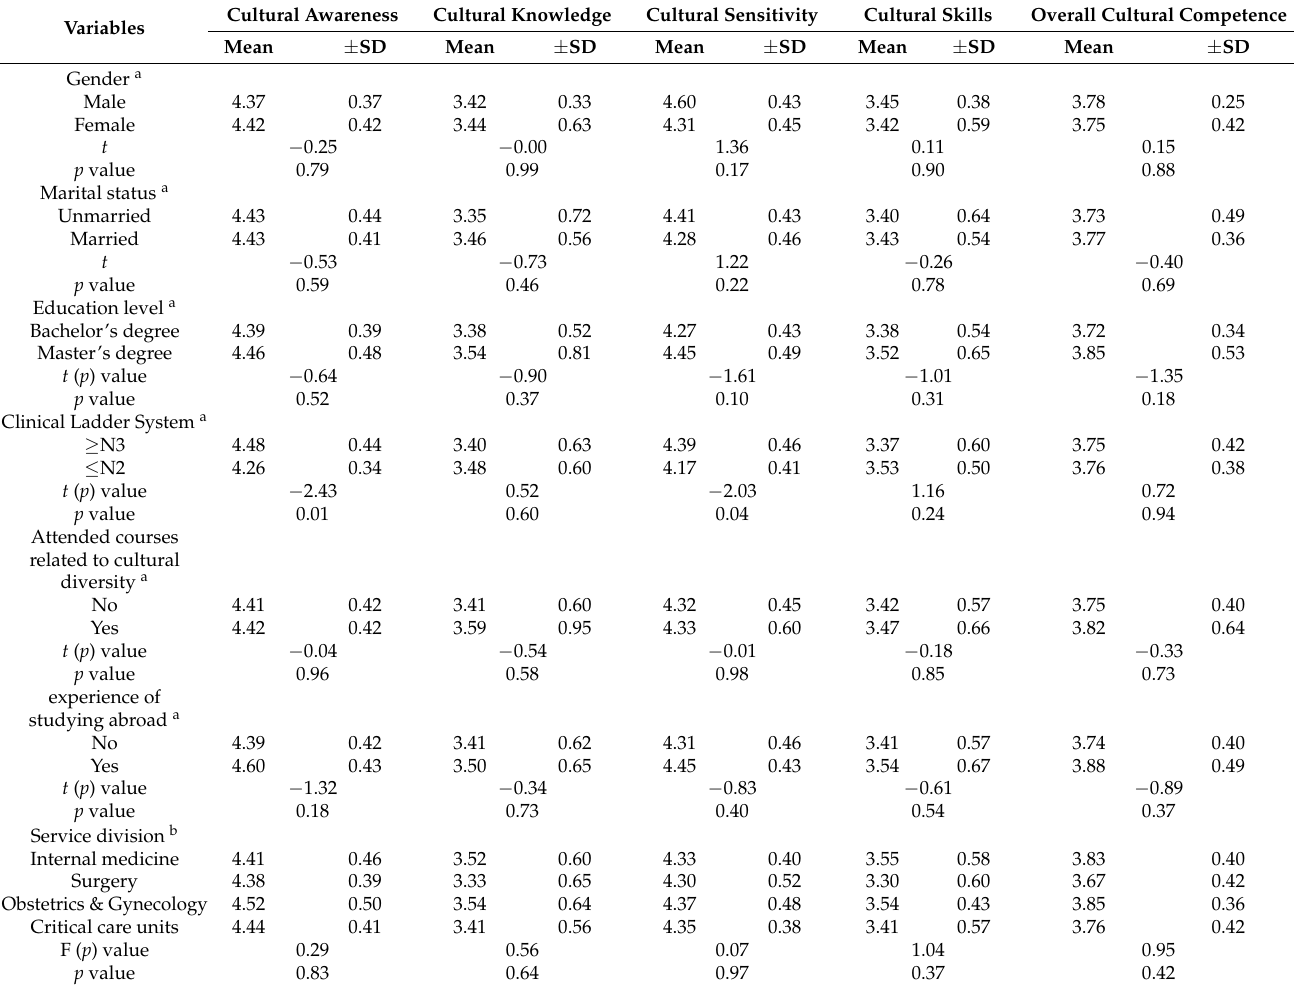
Table 4. Differences among participants’ demographic variables and cultural competence